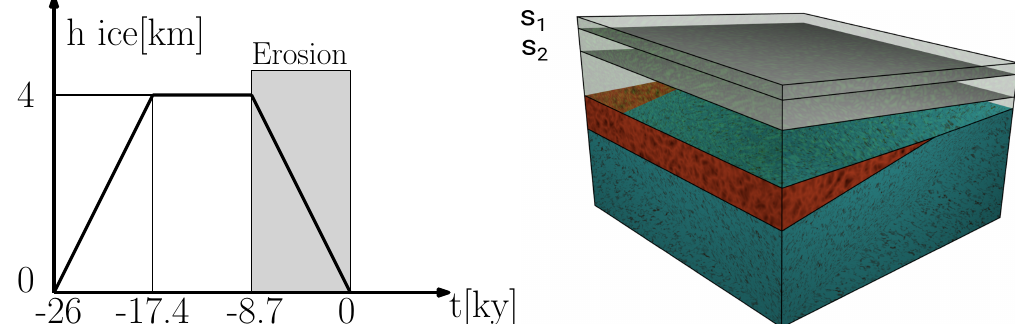
Figure 8. The evolution of the top surface of the basin due to erosion form configuration S 1 to S 2 is shown during the last part of the simulation, from